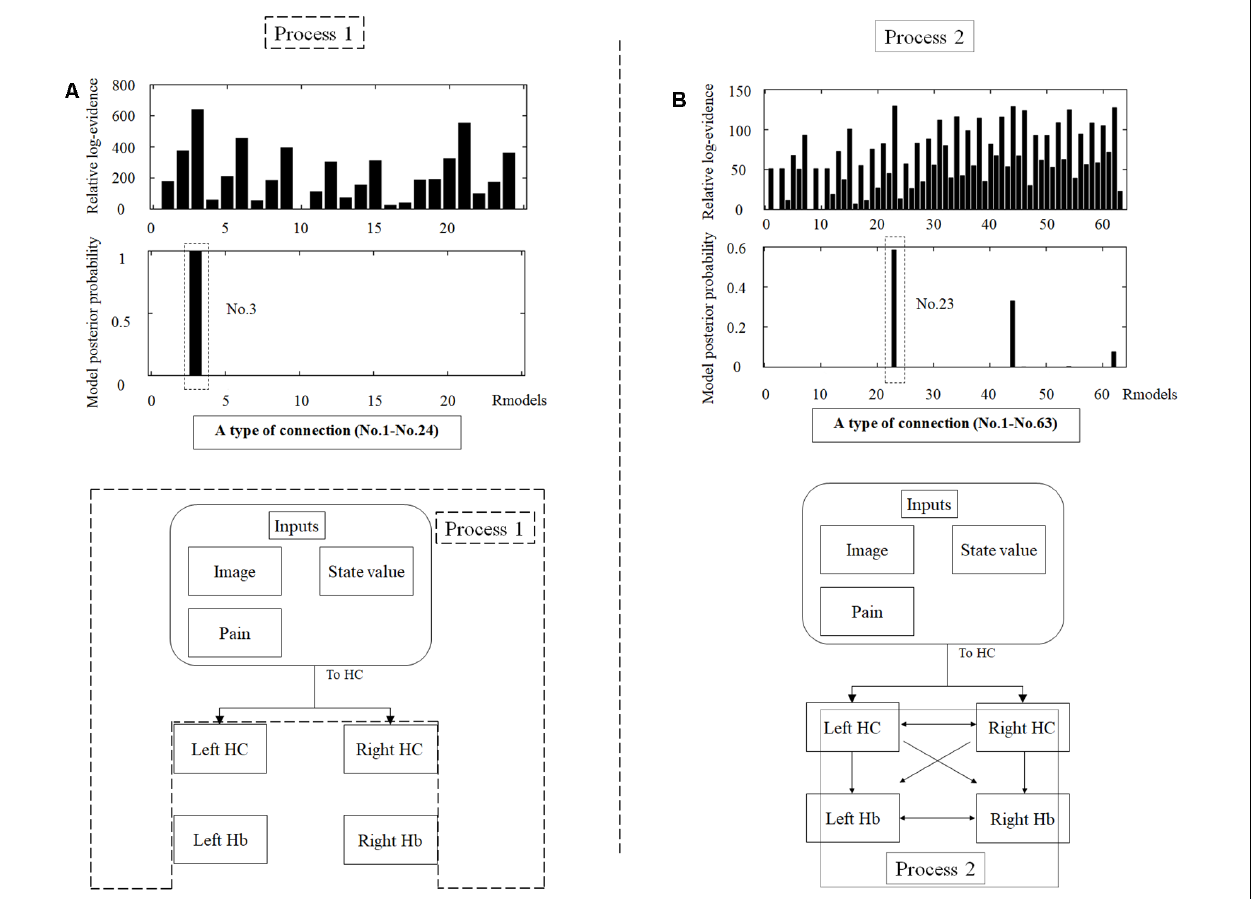
FIGURE 5 | The tables in the upper part of the figure show the relative log-evidence and the posterior probability of models in the combination of inputs and input regions under the fully-connected brain regions (habenula and hippocampus; A ) and the connectivity between the brain regions (B) . The horizontal axis in table A and table B show a type of connection defined in Tables 1 , 2 , respectively. As inputs, we used background images, pain, and state values of the image, as well as the aversive prediction error (APE). As a result, the best model that had inputs of background images, pain, and state values to only the hippocampus (a type of connection; No. 3; Process 1), and that had connections from the hippocampus to habenula was selected among the competitive models (a type of connection; No. 23; Process